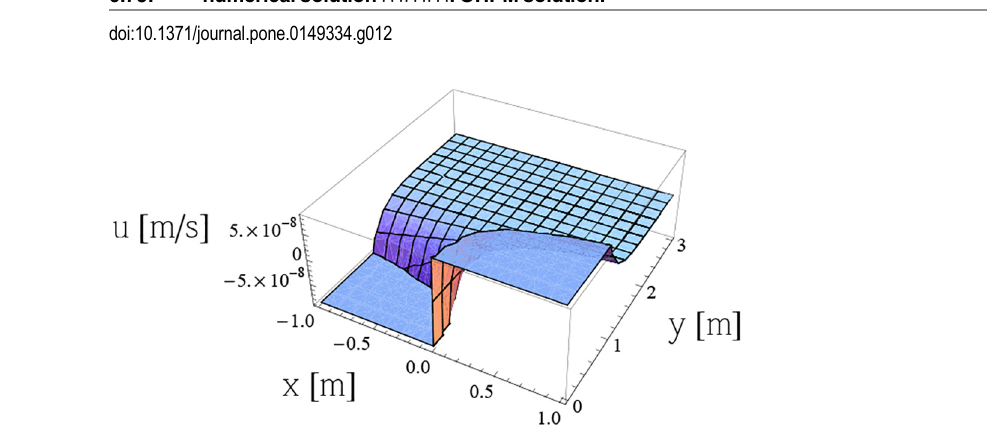
Fig 13. Variation of velocity component u from Eq (6) for m = 1, S = 0.5, λ = 0.3 for toluene at temperature 20°C.